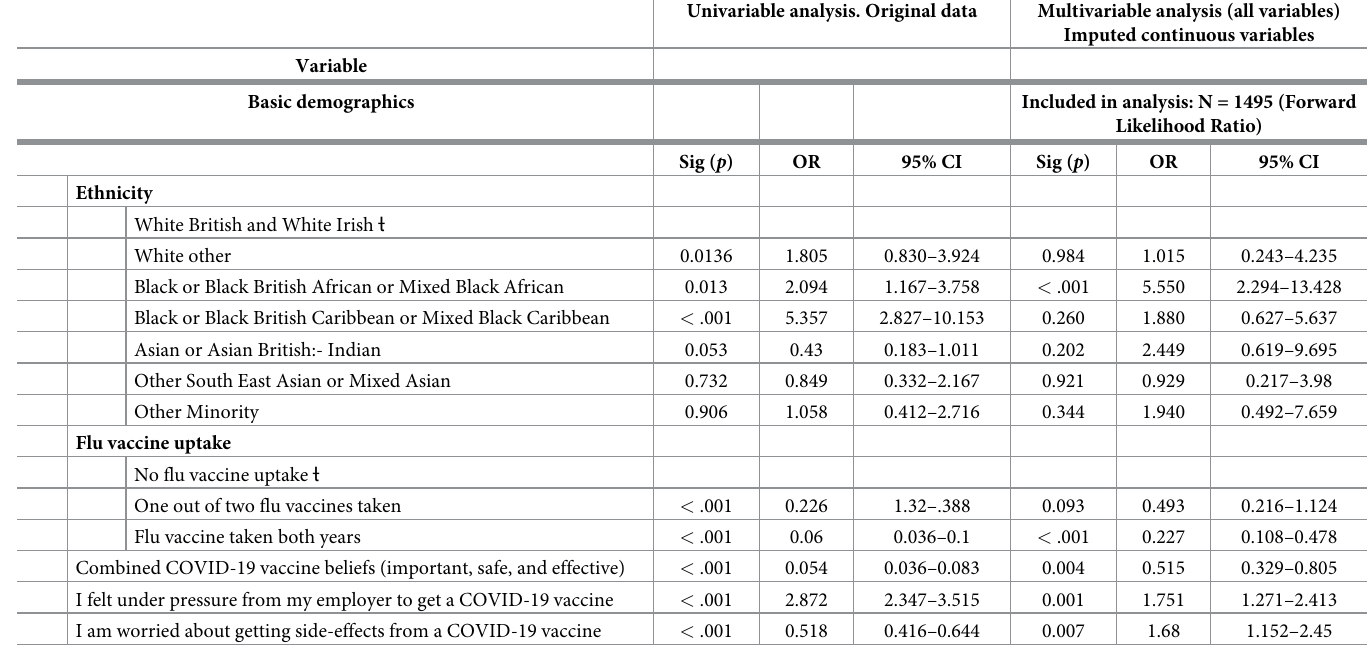
Table 6. A logistic regression analysis of declining or intending to decline COVID-19